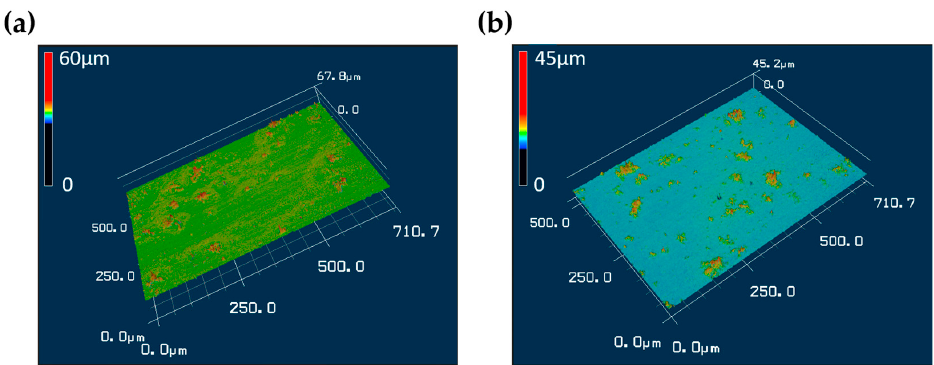
Figure 6. The Color 3D confocal images of ( a ) BIQ/ZnO NRs and ( b ) BIQ/SiO 2 . Finally, the photosensing performance of BIQ/ZnO NRs devices under the UV-, white-, green-, and red-LED illumination was shown in Figure 7a. The light intensity of various LED sources was shown in Table 1. To optimize the photosensing performance of BIQ/ZnO NRs device, deposition of BIQ precursor with different drops (1, 3, and 5 drops) on the ZnO NRs was performed. Figure 7a presented the photosensing behavior of pure ZnO NRs devices and BIQ/ZnO NRs devices with different amounts of drops of BIQ pre- cursor in response to the UV-LED illumination. Devices with 3 drops of BIQ had the strongest photoresponse among all the samples, while devices with pure ZnO NRs had the shortest response and recovery time. When the BIQ covered the ZnO NRs, most UV light was absorbed by the outer BIQ and converted into photoelectrons that required time to undergo charge transfer from the organic BIQ to the ZnO NRs. For the pure ZnO-NRs- based devices illuminated with green LED, white LED, and red LED, a low photoresponse or even noise was detected as compared with the BIQ/ZnO NRs counterpart. Among the BIQ/ZnO NRs devices with various BIQ drops, the devices with 3 drops had a better pho- toresponse than that with 5 drops. An excessive amount of BIQ drops may spread more BIQ on top of ZnO NRs and produce thick BIQ domains. These thick BIQ domains strongly absorbed the illuminated light and reduced the light absorbed by the ZnO NRs. As a result, low photogenerated carriers in the ZnO NRs could decrease the photoconduc- tivity and further deteriorate the device photoresponse. It was noted that devices with BIQ-TlPs exhibited photoresponse only up to green light (around 500 nm), while they had a negligible response in red light. By contrast, devices with BIQ were capable of red-light detection as seen in Figure 7d. The extension of the spectral response for the BIQ/ZnO NRs based devices may result from the lower bandgap of BIQ compared with that of BIQ- TIPs. Without the four TIPs bonding to the BIQ molecules, the interlayer stacking of BIQ is closer than that of BIQ-TIPs to reducing the bandgap of BIQ. The sensitivity of BIQ/ZnO NRs devices was better than that of BIQ-TIPs/ZnO NRs devices under UV and green LED illumination as shown in Table 2. Table 1. The light intensity of various LED sources. UV LED White LED Green LED